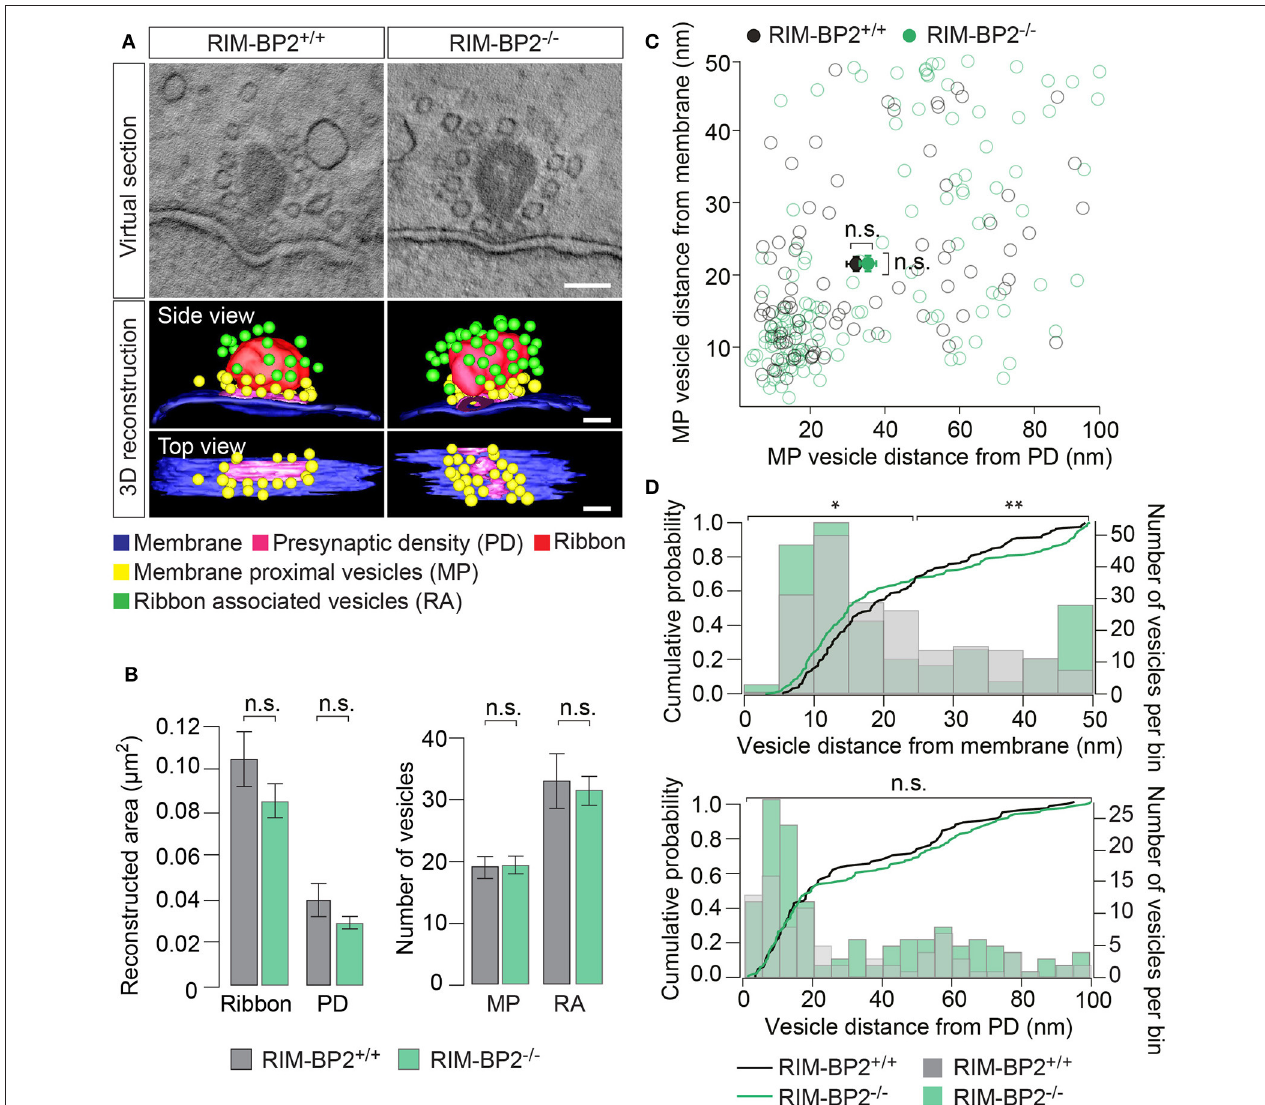
FIGURE 9 | RIM-BP2 regulates the distance of SVs to the presynaptic membrane. (A) Exemplary virtual sections of RIM-BP2 − / − and RIM-B2 + / + ribbon synapses (Top) and side and top view of respective 3D models (Bottom). The overall synapse ultrastructure in RIM-BP2 − / − IHCs was normal: Synaptic ribbons (red) were anchored to the presynaptic membrane (blue) via a presynaptic density (PD, pink). SVs that were located within a 100nm distance from the PD and with a membrane-to-membrane distance of ≤ 50nm away from the presynaptic plasma membrane were classified as “membrane proximal” SVs (MP-SVs, yellow). SVs that appeared within 80nm around the presynaptic ribbon within the first SV layer around the ribbon were considered as “ribbon associated” SVs (RA-SVs, green). Scale bar: 100nm (B) Quantitative analysis of electron tomograms: reconstructed ribbon (Student’s t -test p = 0.13) and PD area (Wilcoxon rank test p = 0.13) (left) as well as the average number of MP (Student’s t -test p = 0.14) and RA (Student’s t -test p = 0.76) SVs (right) were unaltered in RIM-BP2 − / − AZs ( n = 9, N = 2) compared to RIM-BP2 + / + AZs ( n = 9, N = 2). Data represent grand averages, mean ± SEM; Significance level: n.s. p ≥ 0.05; n = number of tomograms, N = number of mice; age of mice: p21 (C) shortest (membrane-to-membrane) distance of MP-SVs [from B] to the plasma membrane and presynaptic density. Plot shows distances of individual SVs (open circles) and mean ± SEM (closed circles) in RIM-BP2 − / − AZs ( n = 9, N = 2) and RIM-BP2 + / + AZs ( n = 9, N = 2) with no significant difference regarding the average distance of MP SVs to the membrane (Student’s t -test p = 0.8) or the PD (Wilcoxon rank test, p = 0.6). (D) Distribution of MP-SVs (B) regarding their shortest (membrane-to-membrane) distance to the plasma membrane (Top) and the PD (Bottom). Histograms show the number of SVs (bin size 5nm, right y-axis) with respect to their distance to the plasma membrane (Top) or PD (Bottom). The cumulative density function (solid line) shows the probability of SVs (left y-axis) being located at a specific distance to the membrane (Top) or the PD (Bottom). The Kolmogorov-Smirnov test was used to compare the probability distribution of SVs. Top: A large fraction (70%) of SVs was located within ∼ 25nm and a small fraction (30%) of SVs was located within ∼ 25–50nm away from the plasma membrane. A significantly different distribution of SVs was observed for both the large ( p = 0.004) and the small ( p = 0.02) fractions of MP-SVs. Bottom: No difference in the distribution of SVs was observed with respect to the PD ( p = 0.7). Comparing the distribution of SVs from the small and large pool as defined for the plasma membrane distribution, but with respect to the PD, also revealed no difference in the SV distribution with respect to the PD (small fraction: p = 0.6, large fraction p = 0.07). (C,D) Significance levels: n.s. p ≥ 0.05, * p < 0.05, ** p <